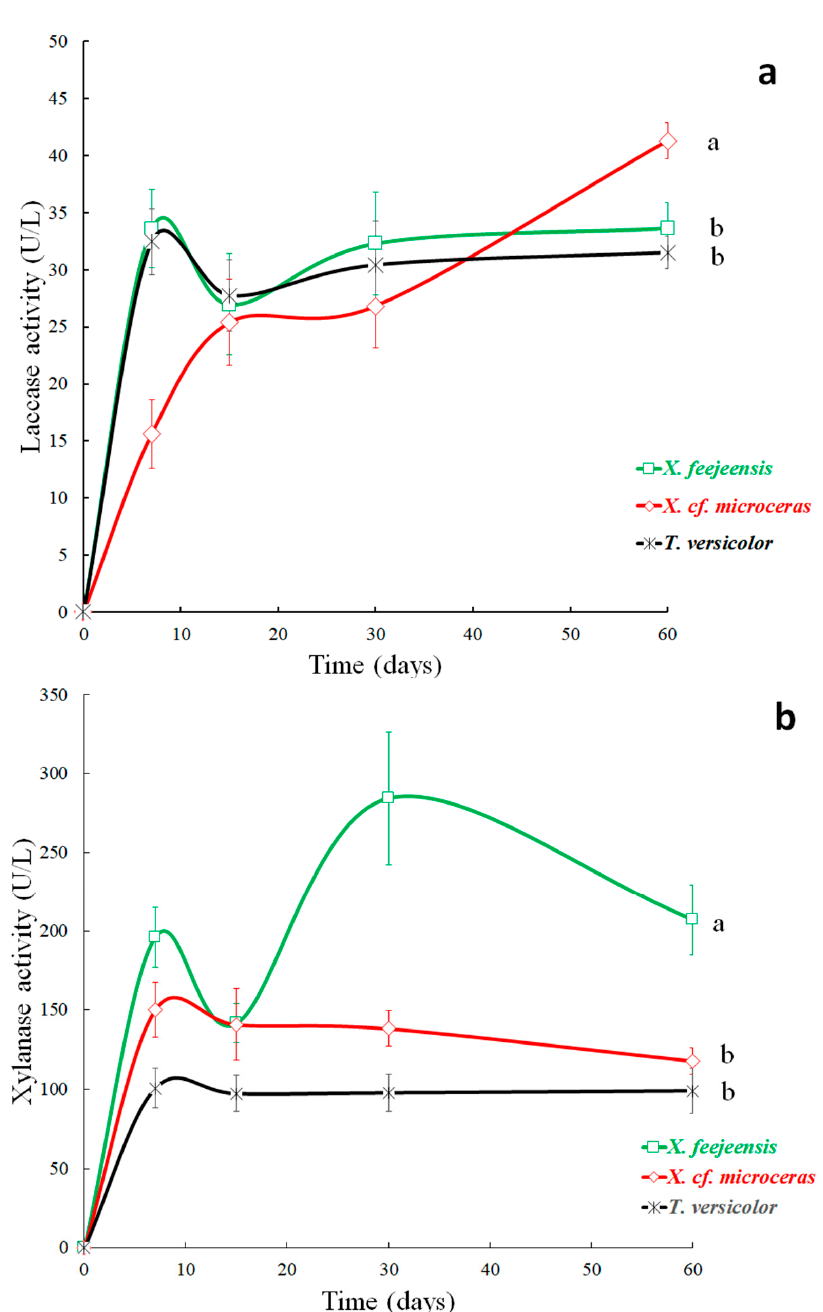
Figure 3. Lignin ( a ) and cellulose ( b ) degradation of BGR’s by native fungi of Xylaria spp. and T. versicolor in solid state fermentation. The bars show the standard error of the mean measured activity of the four samples analyzed on each sampling day. Different letters ( a , b ) indicate significant difference ( p ≤ 0.05%, HSD Tukey).